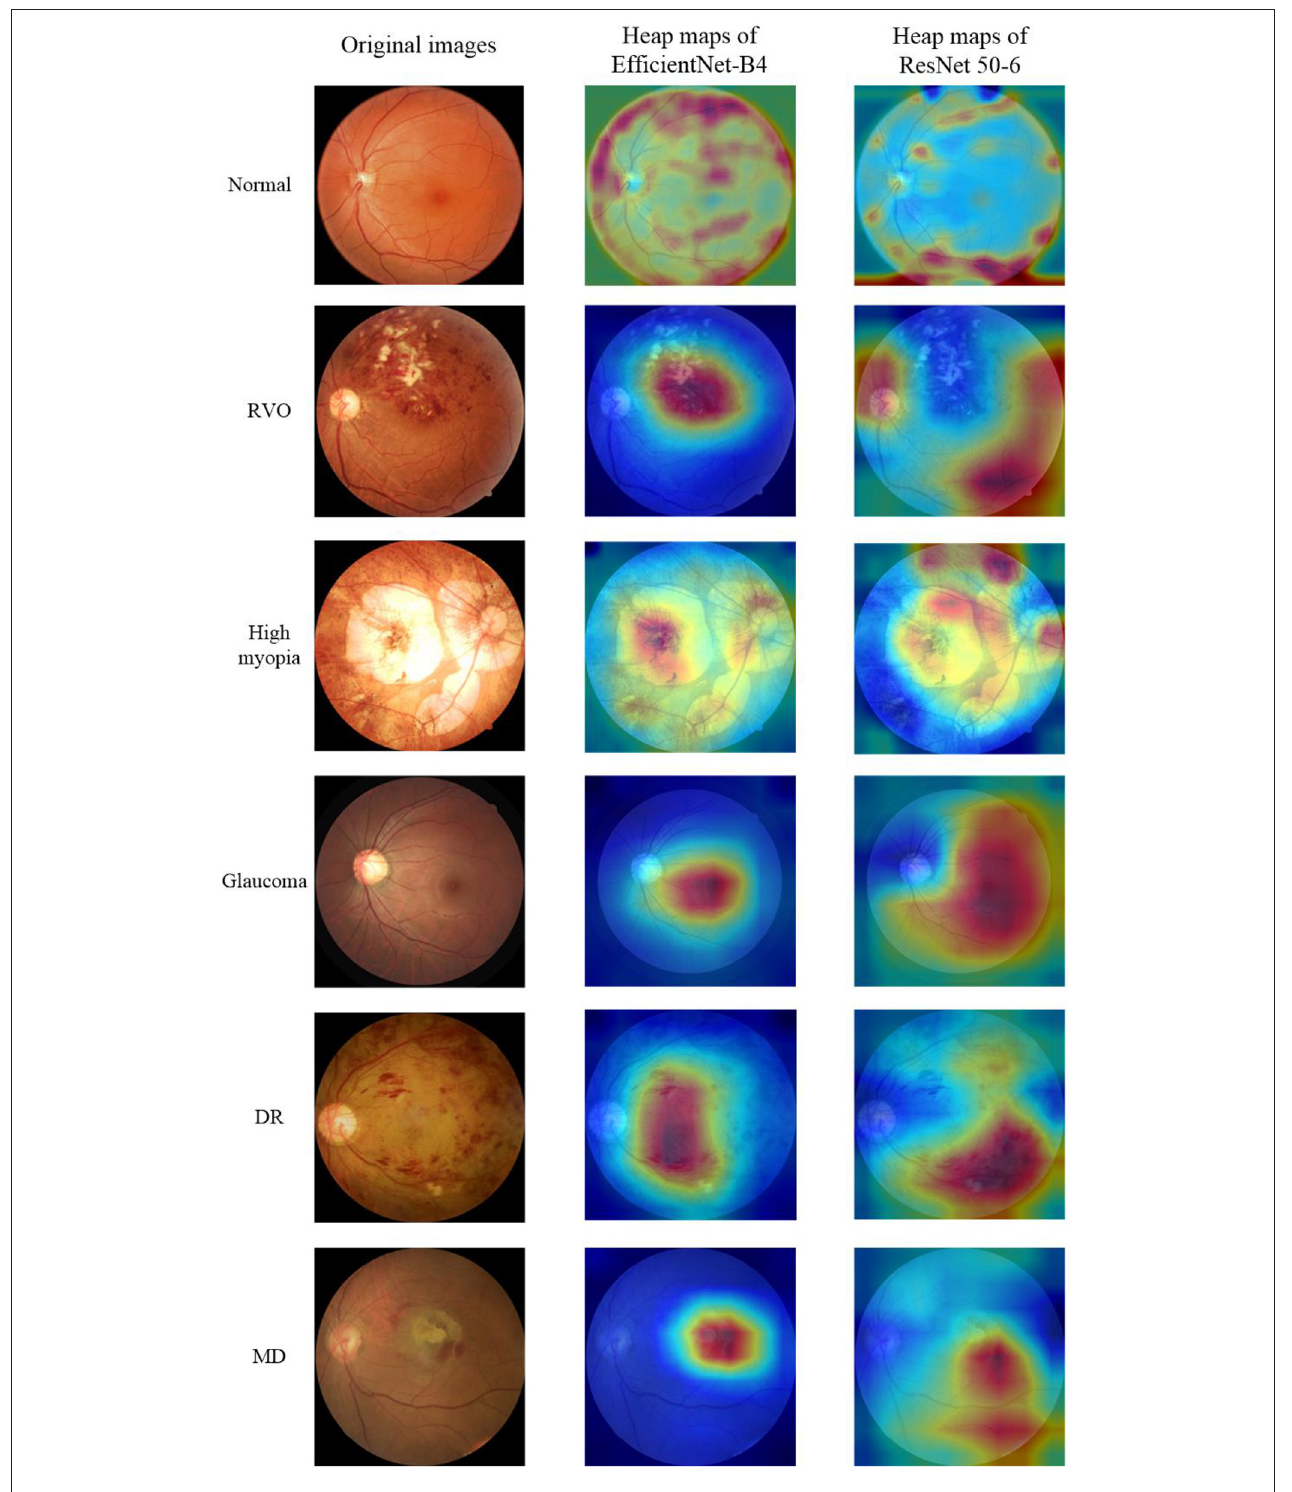
FIGURE 1 | Original Images and heap maps of the normal fundus and five common retinal diseases. the figure that the focus area marked by the heat map of the focus area marked by the ResNet 50-6 model is slightly EfficientNet-B4 model is more accurate, while the accuracy of the